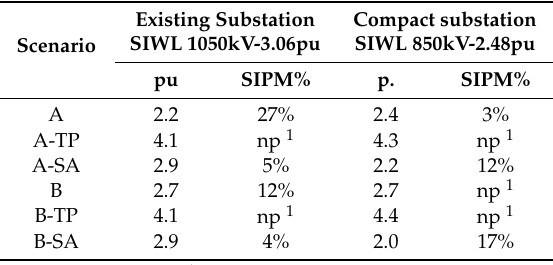
Table 7. Switching overvoltages for existing and compact substations with surge arresters; residual margins in